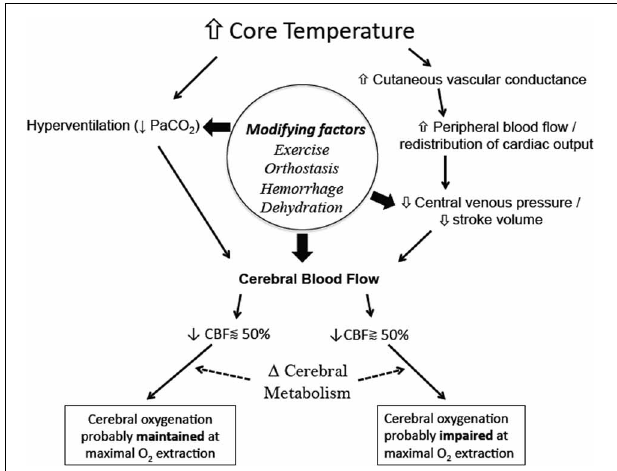
FIGURE 3 | Simplified schematic of the mechanisms and modifying factors involved with reductions in cerebral blood flow and ultimately cerebral oxygenation during whole-body hyperthermia. Global cerebral oxygenation is likely impaired when CBF is reduced beyond 50%, i.e., a critical blood flow is reached at maximal levels of oxygen extraction. Changes in cerebral metabolism will alter the theoretical critical blood flow limit, while regional changes in metabolism and blood flow can yield regional differences in cerebral